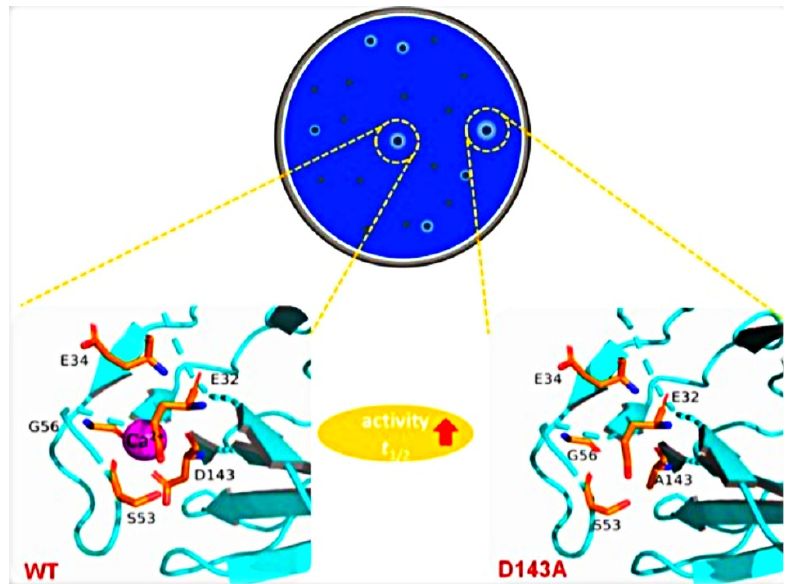
Figure 4. Mutant with enhanced thermostability generated through direct evolution [32].